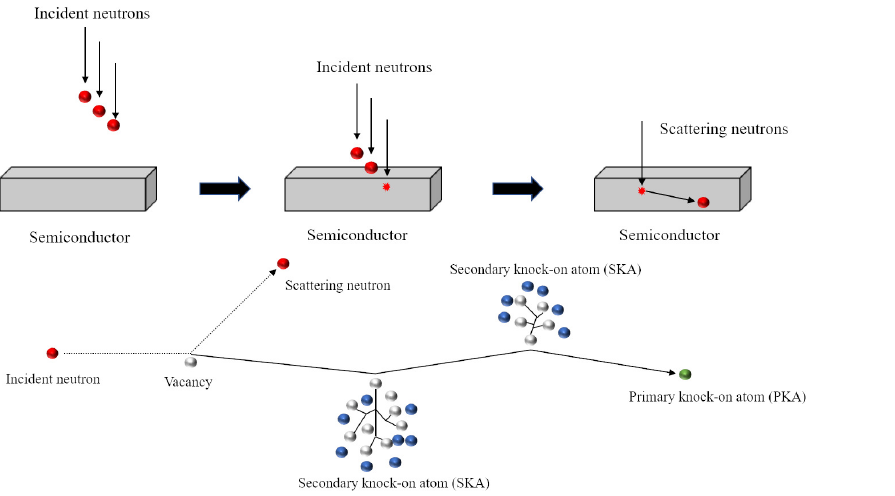
Figure 2. The process of neutron irradiation produces primary knock-on atoms and secondary knock-on atoms in the semiconductor material.